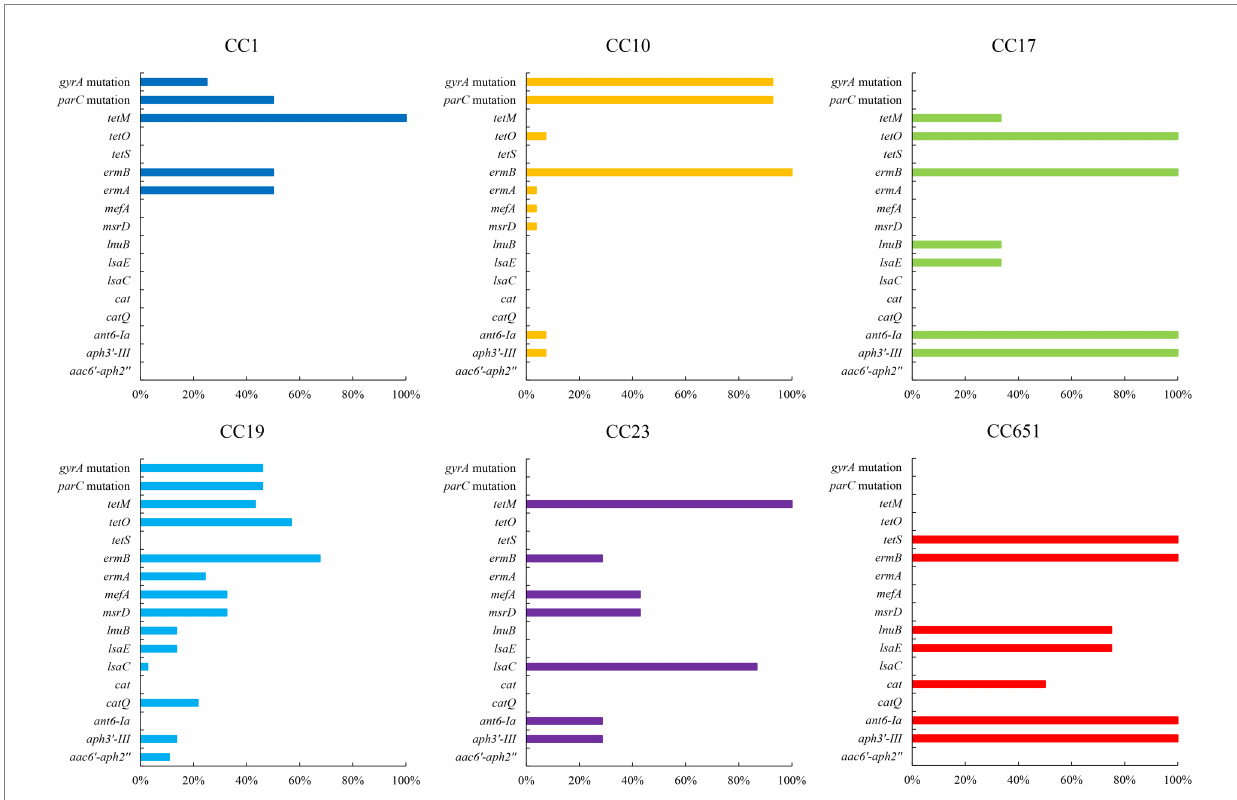
FIGURE 5 Resistance genes of strains with different CCs (%). Only antibiotic resistance genes with significant difference among CCs are included ( p <